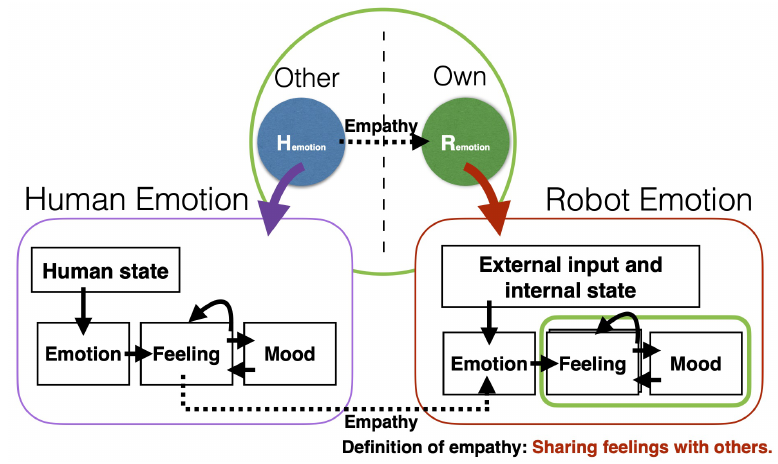
Figure 7. The information flow of the robot’s emotional model.